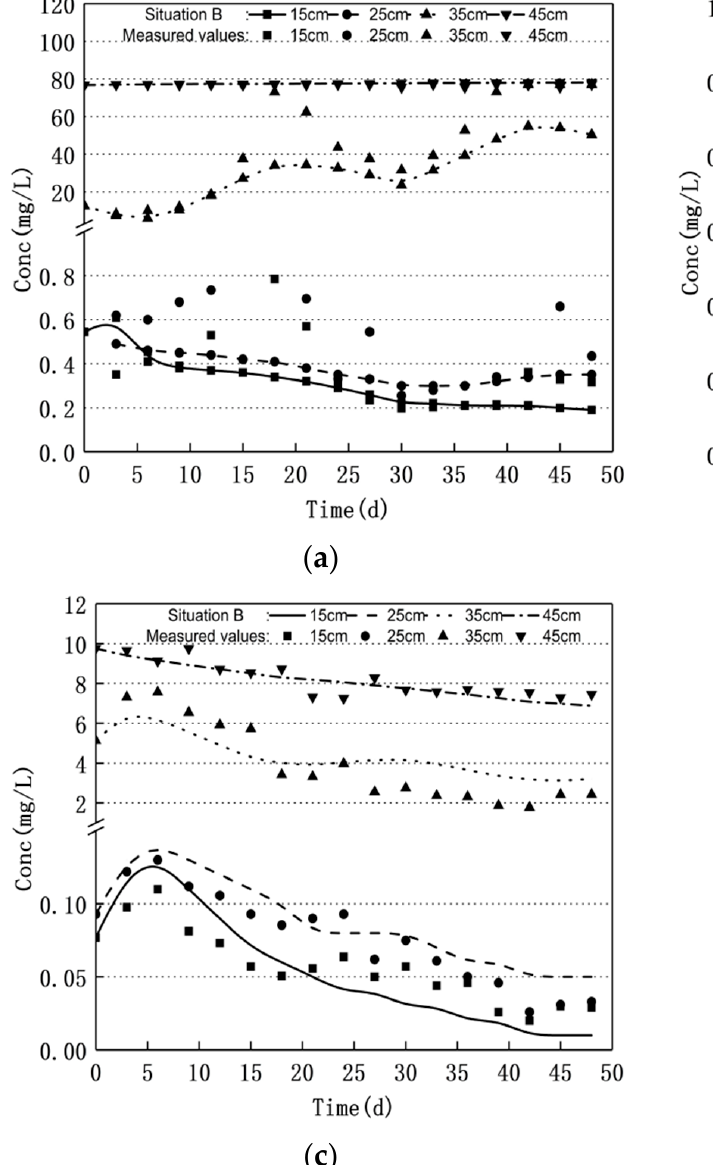
Figure 14. The measured results of fine sand and the dynamic process of nitrogen in situation B (( a ) nitrate nitrogen; ( b ) nitrite nitrogen; ( c ) ammonium nitrogen).